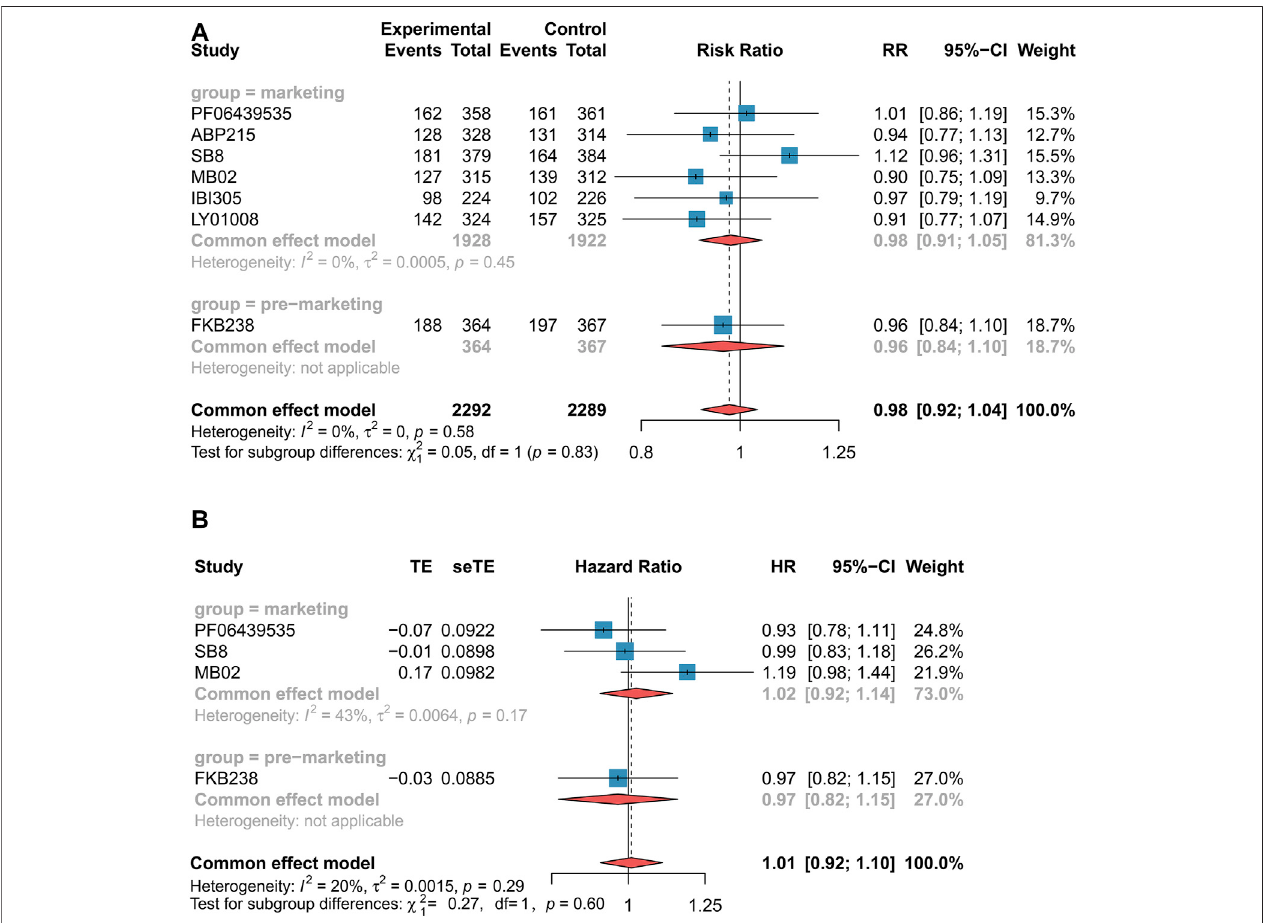
FIGURE 2 | Forest plots of objective response rate and progression-free survival for non-small cell lung cancer patients. (A) Objective response rate. (B) Progression-free survival. These drugs were grouped by marketing. The marketing drug included PF-06439535, ABP 215, SB8, MB02, IBI305, and LY01008, while FKB238belongedtothepremarketingdrug.Objectiveresponseratewasmeasuredusingriskratio(RR),andprogression-freesurvivalwasmeasuredusinghazardratio (HR).IftheRRvaluewashigherthan1,itfavoredthebiosimilargroup;otherwise,itfavoredthereferencebiologicsgroup.IftheHRvaluewasmorethan1,itfavored the biosimilar group; otherwise, it favored the reference biologics group. CI, con fi dence interval; RR, risk ratio; and HR, hazard ratio.